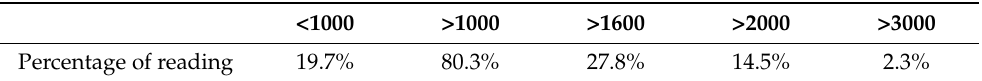
Table 3. Total concentration of CO 2